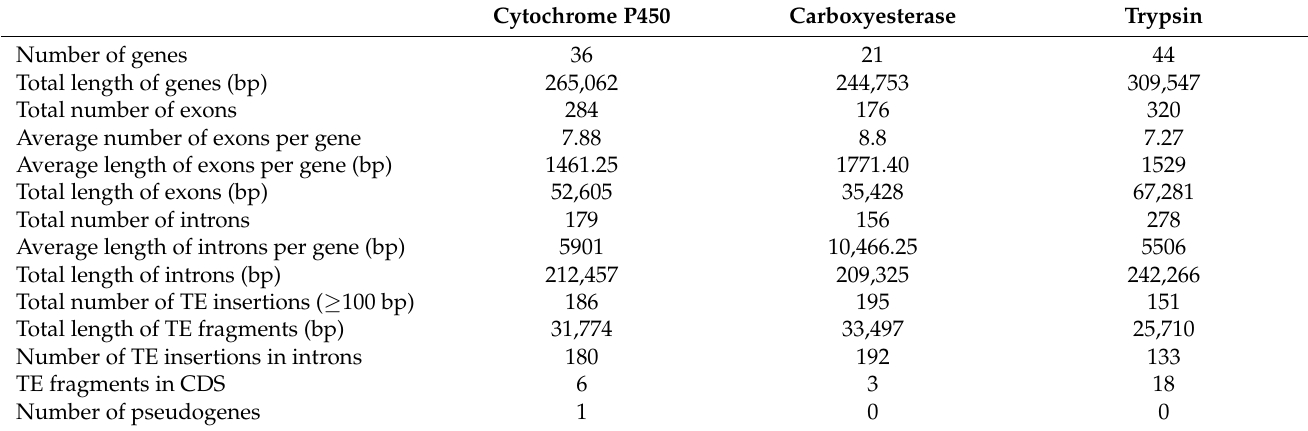
Table 3. Detailed information of the three families of functional genes, and transposable elements’ insertions in